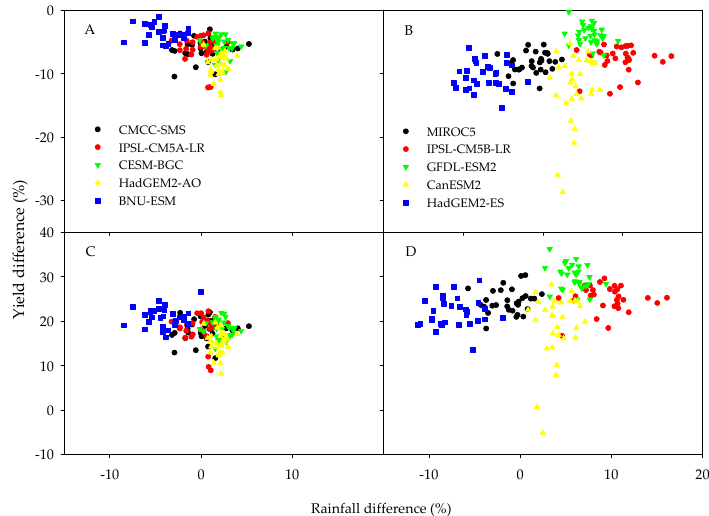
Figure 13. Relationship between average change in total rainfall amount over the growing season and the corresponding simulated change in grain yield under ( A ) RCP 4.5 with ambient CO 2 , ( B ) RCP 8.5 with ambient CO 2 , ( C ) RCP 4.5 with elevated CO 2 and ( D ) RCP 8.5 with elevated atmos- pheric CO 2 , for Tamale, Ghana.